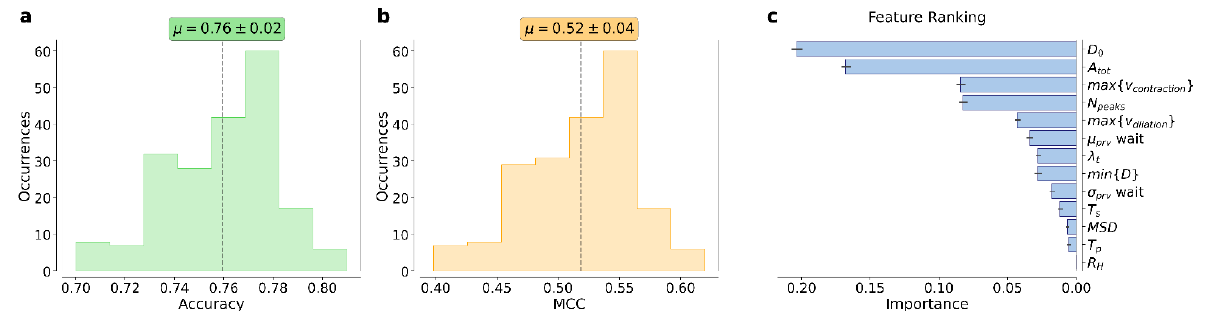
Figure 2. Results obtained by the proposed machine learning pipeline for the automated classifica- tion of ON vs. Healthy patients analyzing the set of features extracted from the PLR signals. ( a ) Distribution of the accuracy scores and mean ± standard deviation, achieved by the proposed pipeline on 200 different 5-fold cross-validations procedures. ( b ) Distribution of the Matthews Correla- tion Coefficient scores and mean ± standard deviation, achieved by the proposed pipeline on 200 different 5-fold cross-validations procedures. ( c ) Ranking of the top-performing features identified by the Ridge classifier. The feature importance was assessed by computing the loss of accuracy when permutating each variable. Bars are the 95% confidence intervals of 5000 bootstrap resamples from 500 different random permutations.